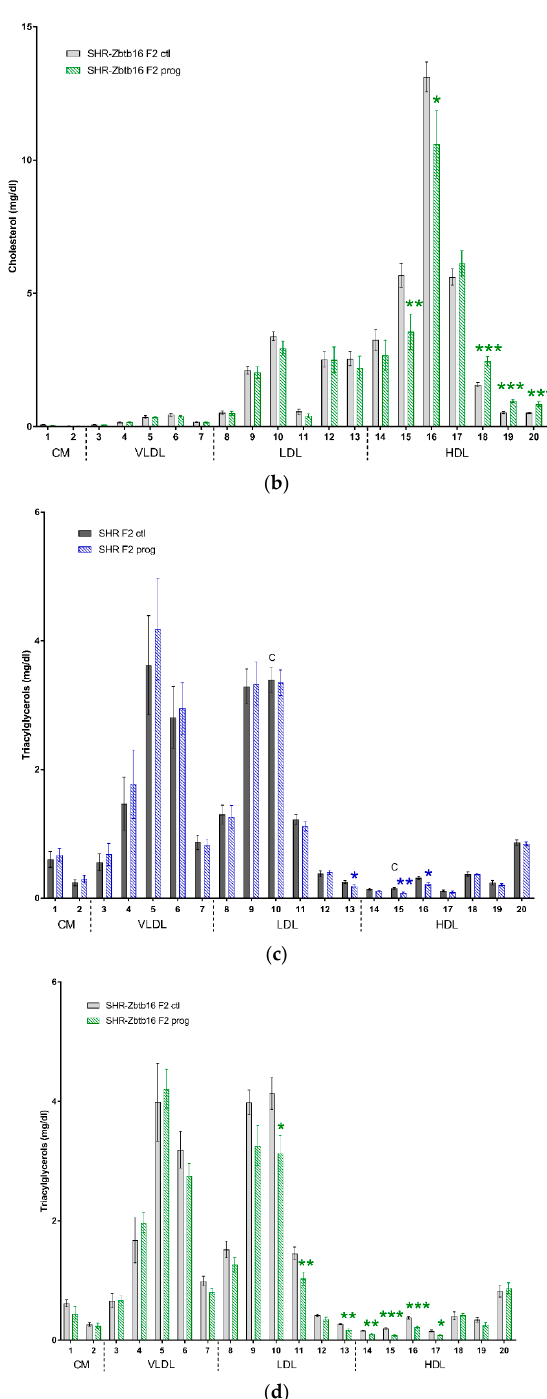
Figure 9. Lipoprotein profile. The cholesterol ( a , b ) and triacylglycerol ( c , d ) content in 20 lipoprotein subfractions in adult SHR F2 control male o ff spring (dark grey bars), SHR-Zbtb16 F2 control male o ff spring (light grey bars), F2-programmed SHR male o ff spring (blue patterned bars), F2-programmed SHR-Zbtb16 male o ff spring (green patterned bars) in 6 months of age. The strain comparison using the post-hoc Fisher’s least significant di ff erence test of the two-way ANOVA for STRAIN and PROGRAM as major factors are indicated as follows: * p < 0.05, ** p < 0.01, *** p < 0.001. E ff ect of programming in SHR and SHR-Zbtb16 strains is represented by blue and green asterisks (*), respectively. ( a , c ) C represents STRAIN di ff erences between F2 SHR and SHR-Zbtb16 control males, C15 *, C16 **, C17 *, TG10 *, TG15 *, which were all higher in SHR-Zbtb16 F2 control